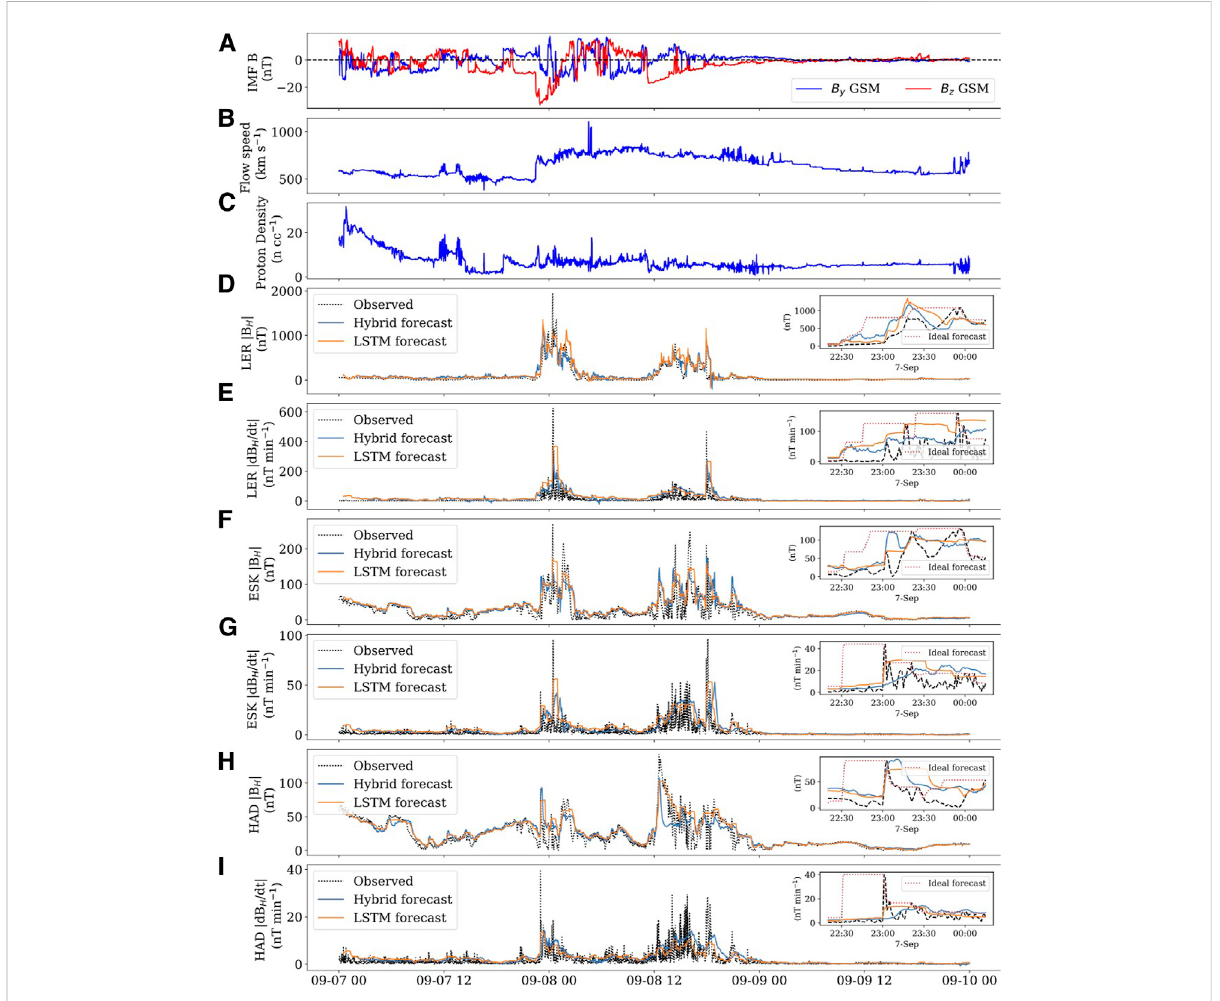
FIGURE 3 DSCOVR measurements and ground observatory measurements, and predictions for the 7th-9th September 2017 storm. Solar wind (A) IMF B Y and B Z components, (B) the solar wind speed velocity and (C) density. Measured (black) and 30-min forecast (blue for hybrid, orange for LSTM) horizontal magnetic fi eld and its time derivative at (D,E) LER, (F,G) ESK and (H,I) HAD observatory. The inset fi gures show observed B H and d B H | forecast | B H | max 30 and | d B H max 30 during the storm onset around midnight on 7th September 2017. Ideal forecasts are shown in d t